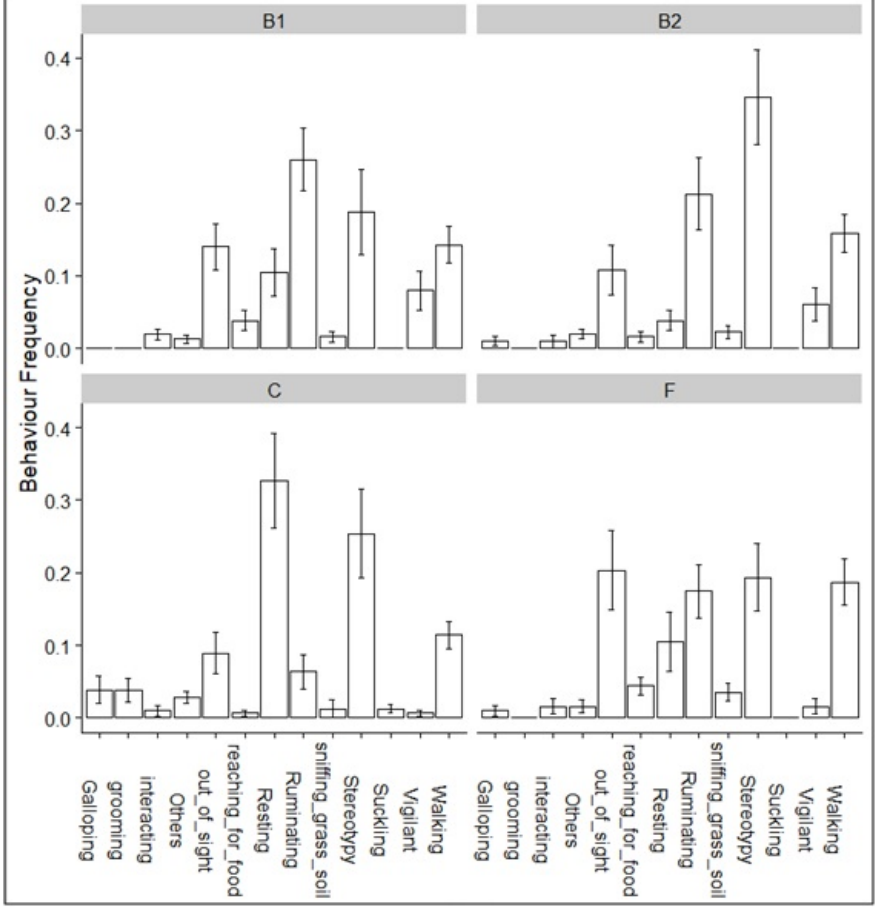
Figure 2. Behaviour among all four giraffe during total observation period at Zoological Garden